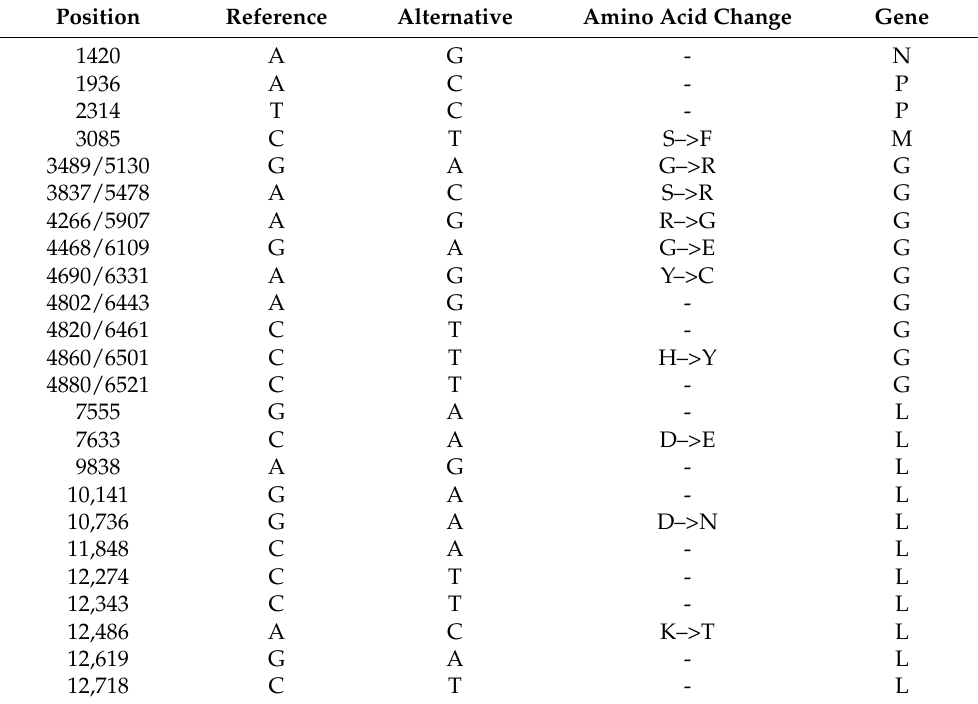
All adult mice inoculated i.c. with the pooled P5 sample remained healthy during the entire observation period, indicating no (partial) reversion to